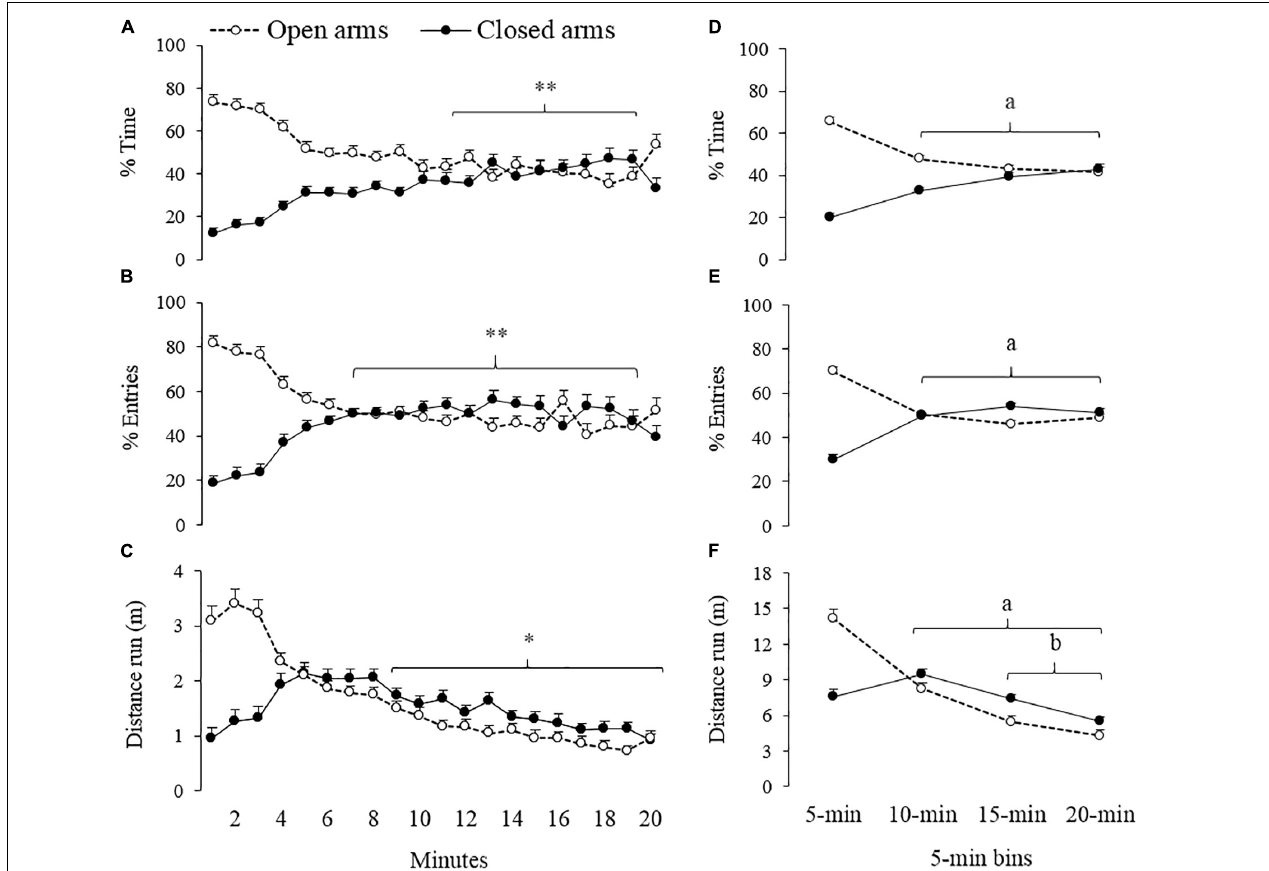
FIGURE 1 | Spatio-temporal analyses of exploratory behavior of gerbils ( n = 33) exposed to 20-min session in the EPM. Left panels (A–C) show minute-by-minute session data and right panels (D–F) the same data in 5-min bins. ∗∗ different from 1 to 3-min for open and closed arms, ∗ different from 1 to 5-min for open arms, a different from 0 to 5-min for open and closed arms, b different from 6 to 10-min for open and closed arms ( p <